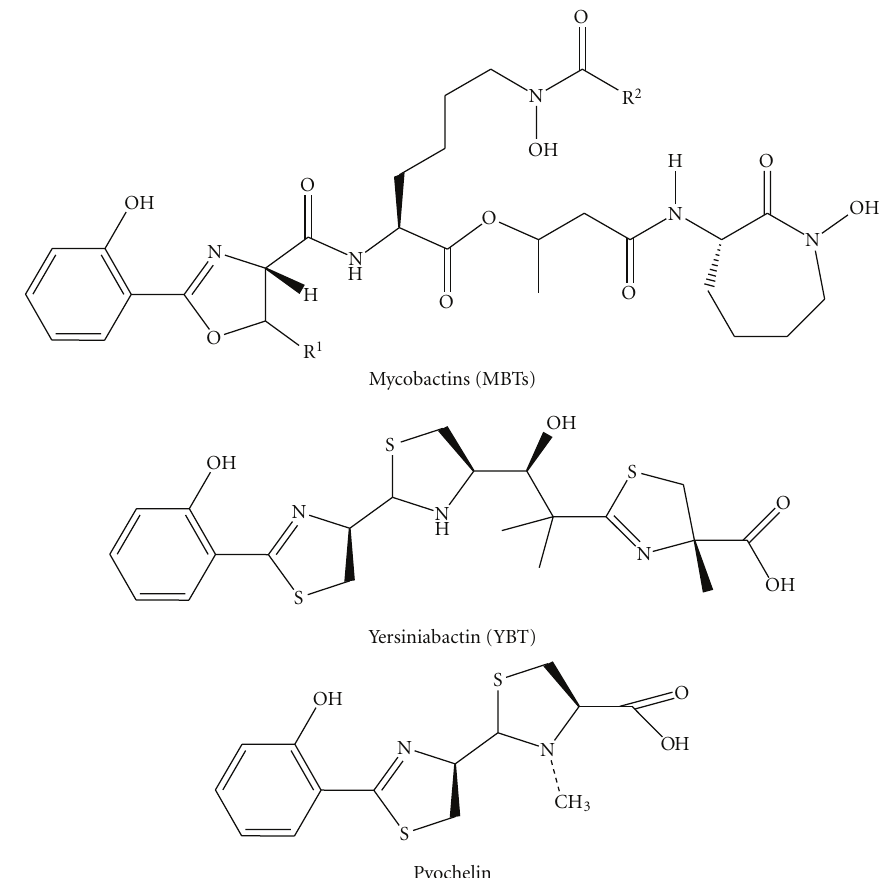
Figure 8: Structures of mycobactins, yersiniabactin, and